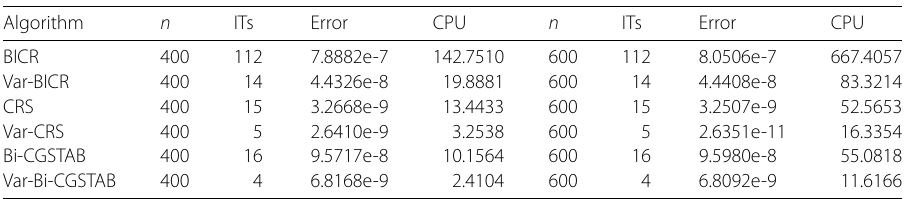
Table 2 Numerical results for Example 4.1